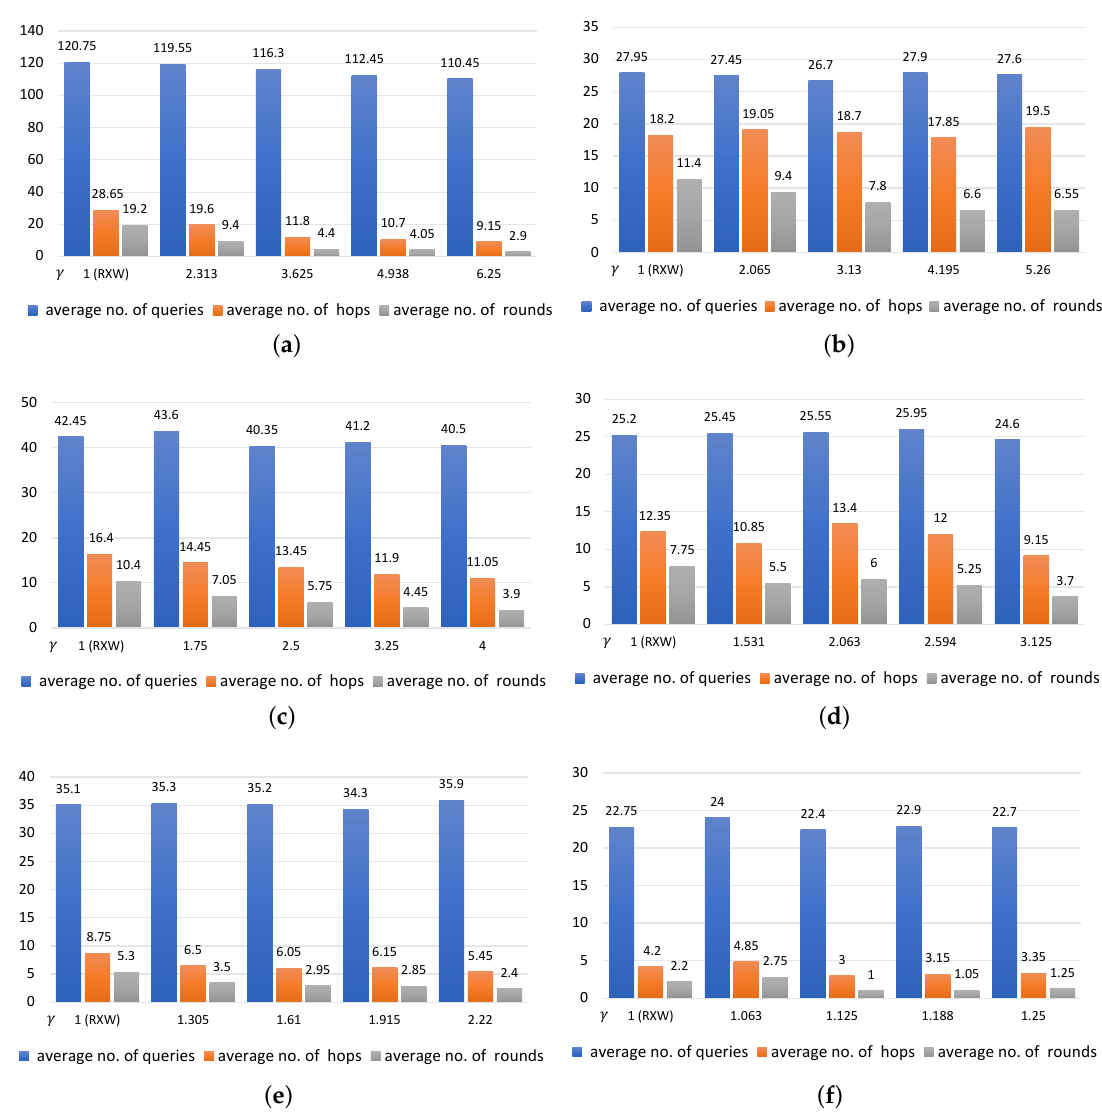
Figure 5. Comparing RXW and RXW-G: the number of queries sent to regions and number of hops and number of rounds averaged over 20 runs (vertical axis)for varying γ (horizontal axis) for different values of σ with k = 20. ( a ) σ = 0.16 ( α = 0.20 , β = 0.80 ) ; ( b ) σ = 0.19 ( α = 0.75 , β = 0.25 )